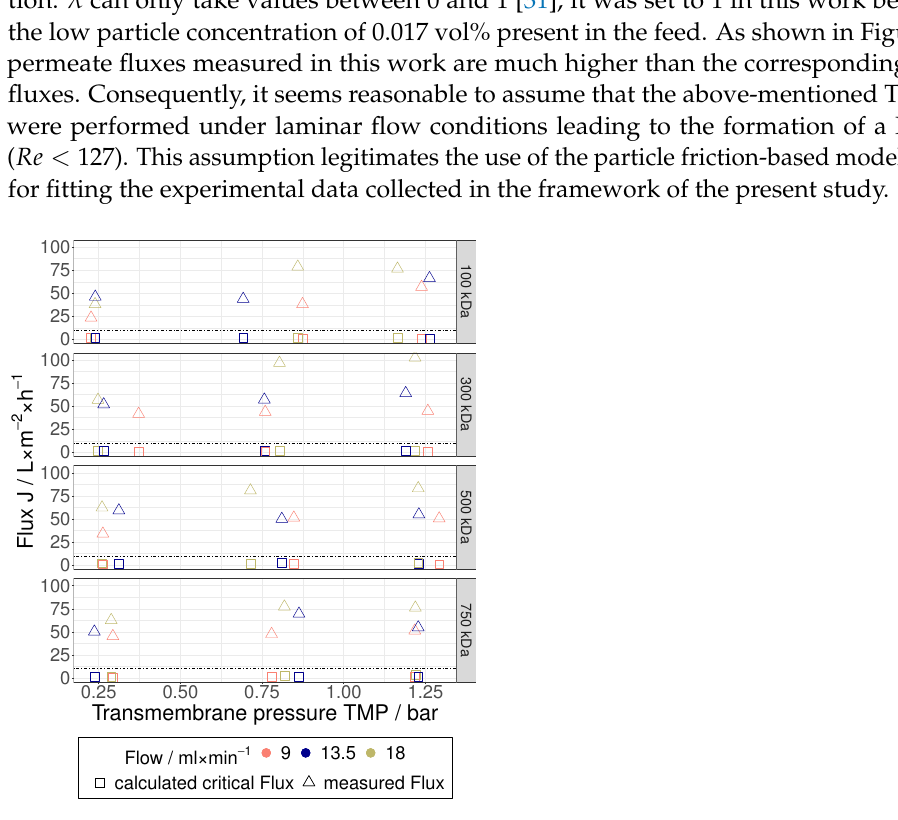
Figure 9. Calculated critical flux J crit depending on the TMP split for the different MWCOs in comparison to the determined